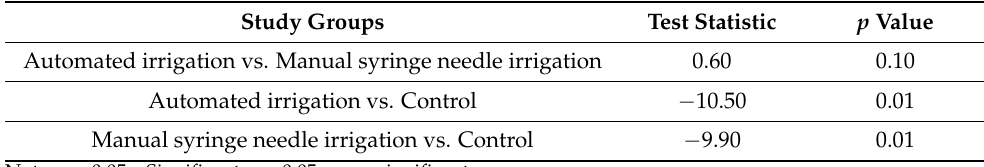
Table 4. Pair-wise Comparison of Mean debris and Smear layer